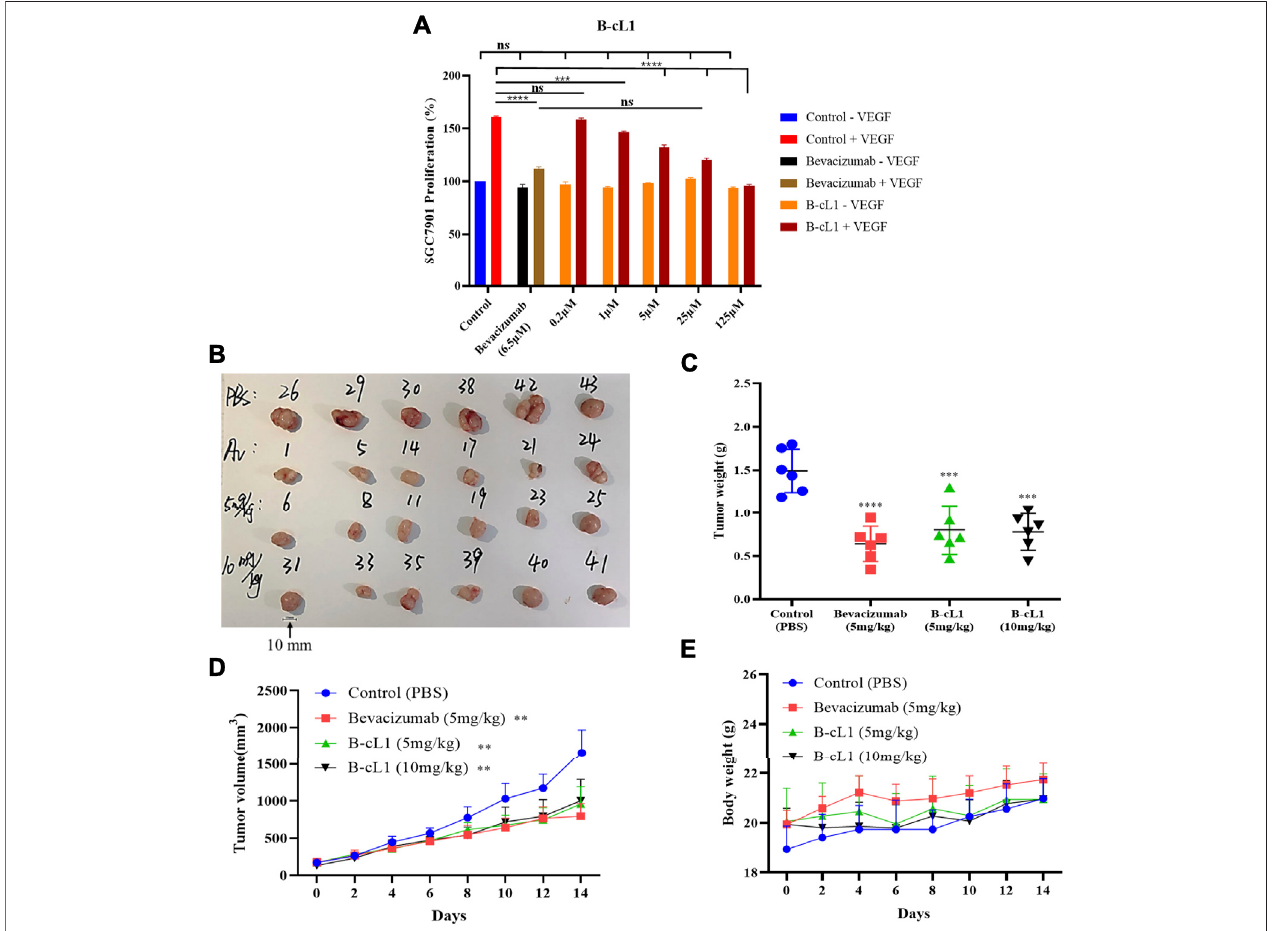
FIGURE8| B-cL1inhibitshumangastriccancerSGC-7901cellproliferationandtumorgrowthonBALB/cnudemiceorthotopictransplantationmodel. (A) Human gastric cancer SGC-7901 cells were cultured inserum-free medium withoutor with50 ng/ml VEGF(negative control − VEGF; positive control + VEGF), treated with0.2, 1,5,25and125 μ MofB-cL1withoutorwith50 ng/mlVEGF;ortreatedwith6.5 μ Mbevacizumabwithoutorwith50 ng/mlVEGF.Therelativecellproliferation(%)were analyzedwithGraphPadPrism 8. (B) Images oftumors separated frommice(numbersrepresentrandomized mouse number) after 14 days ’ treatmentwith B-cL1 (5 mg/kg/day and 10 mg/kg/day), or bevacizumab (Av, 5 mg/kg, once), or PBS as control. (C) Quanti fi cation of tumor weight. (D) Quanti fi cation of tumor volume every 2 days. (E) Quanti fi cation of mice body weight every 2 days. Data are presented as mean ± SD, compared to the control group in one-way ANOVA statistical